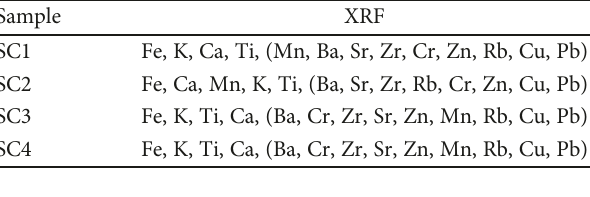
Table 3: Summary of the XRF results obtained for the investigated pottery fragments from the archaeological site of Scifì.